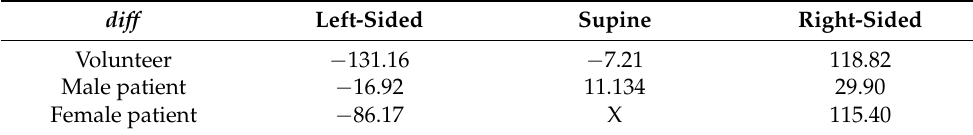
Table 6. The depth difference between the right shoulder and the left shoulder (in mm).